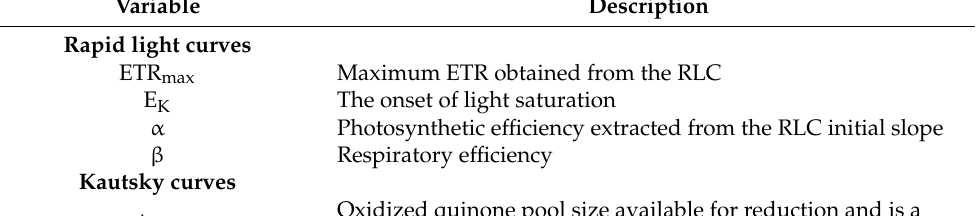
Table 1. Summary of the extracted fluorometric parameters in the analysis. Variable